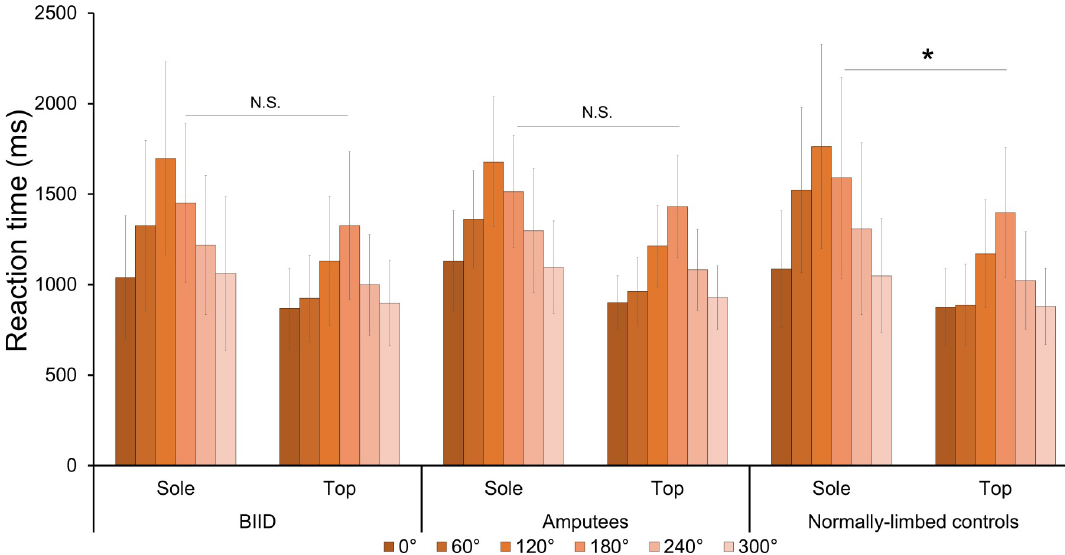
Fig 3. Reaction times for view and orientation per group. Bar graph displaying (untransformed) average reaction times in milliseconds to foot stimuli presented at different views (sole, top), orientations (0–300 degrees) and groups (BIID, amputees, and normally-limbed controls). Note that normally-limbed participants were significantly faster at making judgements about feet viewed from the top at 180 degrees (i.e. 3 rd person perspective, � p = 0.003), while this was not the case for BIID and amputee participants. Top views yielded significantly faster reaction times for all other orientations and all groups (not shown here for clarity sake, p < 0.001 for all comparisons, critical p following Bonferroni-correction was 0.008). N.S. = not significant.